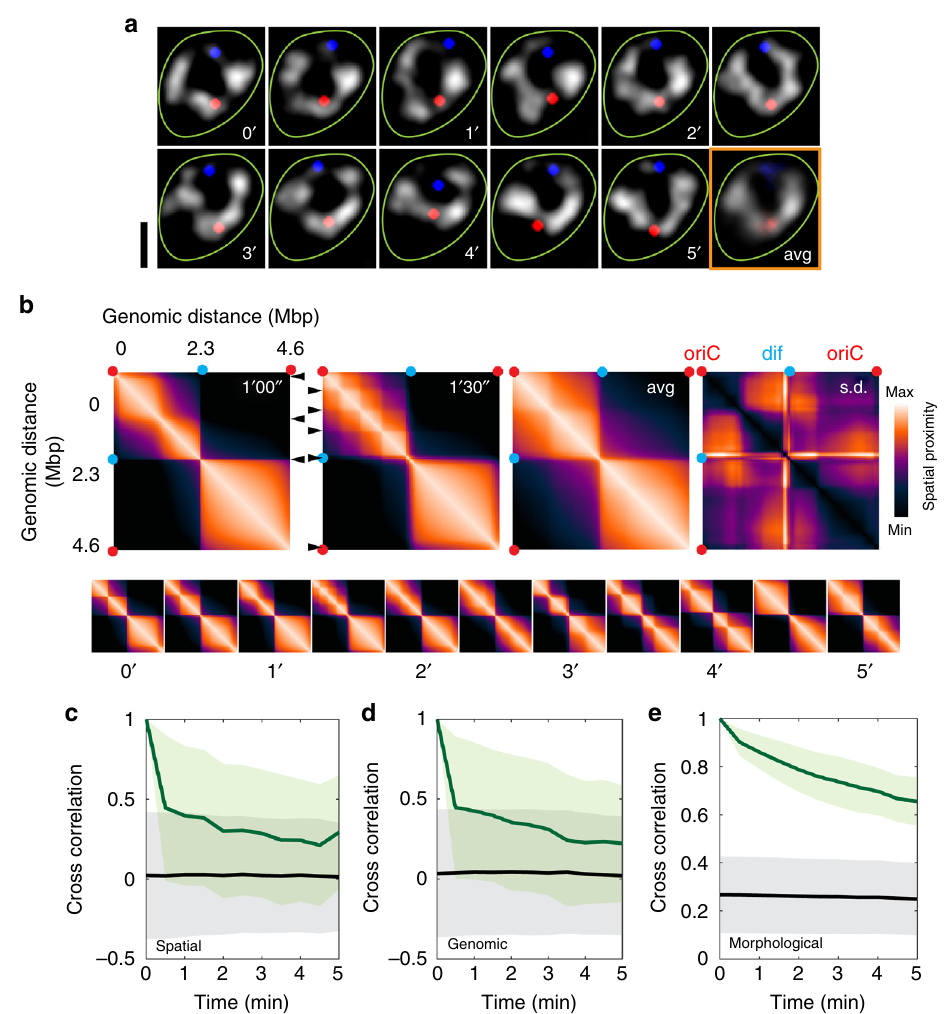
Fig. 4 Temporal dynamics of the circular chromosome of E. coli . a Time-lapse structured-illumination microscopy (2D-SIM) images of a circular chromosome. Chromosomes in grey scale, Ori1/Ter3 localizations shown in red/blue, cell boundary in green. Time stamps are in minutes. The last frame is the time-average. Scale bar, 2 μ m. b DNA spatial proximity maps derived from a single chromosome shown in a. Color bar indicates the level of spatial proximity for genomic loci along the circular chromosome. Arrowheads indicate apparent domain boundaries. Top panels, two consecutive frames, the time-average, and standard deviation values. Bottom panel, all 11 time frames. Red and cyan dots indicate Ori1/Ter3 loci. c – e Cross-correlation functions of individual chromosomes over time (green) compared to that across the cell population at each time point (black). These cross-correlation functions are measured with regard to the DNA density distribution along the contour in, respectively, spatial coordinates ( c ) genomic coordinates ( d ), and their morphology ( e ). Shown are mean and standard deviation values. n =